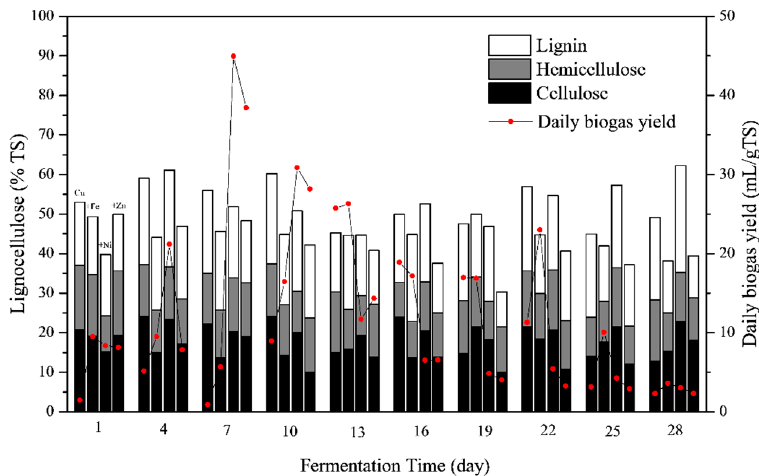
Figure 5. Lignocelluloses contents during the fermentation process. For each day, the column from left to right shows the lignocelluloses contents of Cu, Cu + Fe, Cu + Ni and Cu + Zn treatments, respectively. The compositions of lignocelluloses were shown by stacked bars in the order of cellulose (black), hemicellulose (gray) and lignin (blank) from bottom.